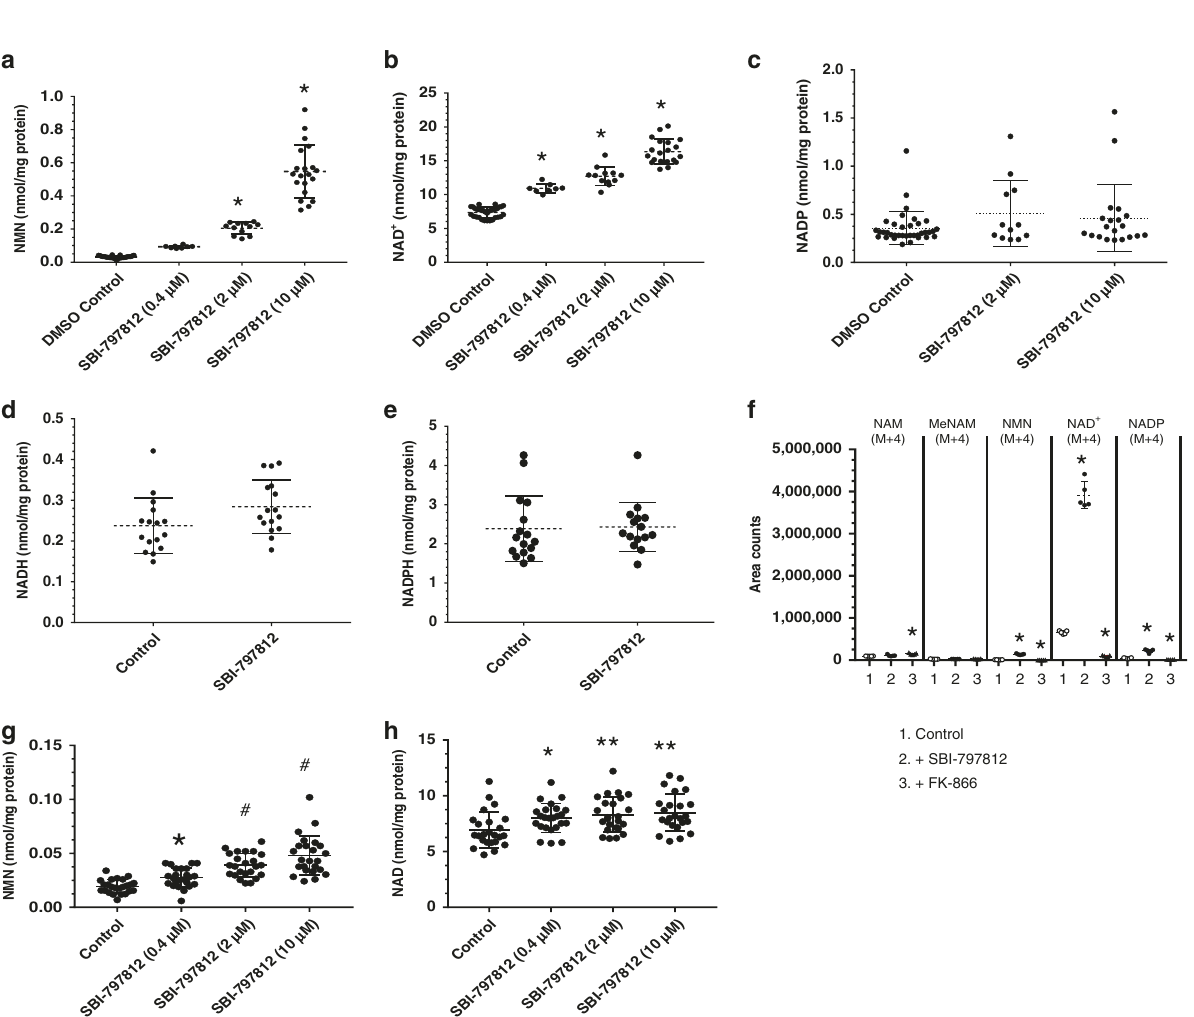
Fig. 4 Effects of SBI-797812 on NAMPT activity in cultured cells. A549 cells treated with SBI-797812 for 4 h. NMN ( a ), NAD + ( b ), and NADP ( c ) were measured by LC-MS/MS. Data shows means ±s.d.; * p < 0.0001 vs. DMSO. NMN: n = 35, 8, 12, 20 for vehicle, 0.4, 2, 10 μ M SBI-797812, respectively; NAD + : n = 32, 8, 12, 20 for vehicle, 0.4, 2, 10 μ M SBI-797812; NADP: n = 36, 12, 20 for vehicle, 2, 10 μ M SBI-797812. One-way ANOVA with Tukey ’ s multiple comparisons test. NADH ( d ) or NADPH ( e ) were not increased in A549 cells treated with SBI-797812 (10 μ M) for 4 h. NADH and NADPH were assayed by LC-MS/MS. Data shows means ±s.d. n = 16 except for NADPH (SBI-797812), n = 15. f NAD + biosynthesis in A549 cells treated for 4h with vehicle, SBI- 797812 (10 μ M) or FK-866 (1 μ M), and 13 C/ 15 N-NAM (20 μ M). NAM(M + 4), MeNAM(M + 4), NMN(M + 4), NAD + (M + 4), and NADP(M + 4) were assayed by LC-MS/MS. Data shows means ±s.d.; n = 5. * p <0.001 vs. Control. One-way ANOVA with Dunnett ’ s multiple comparisons test. g , h SBI-797812 increased NMN and NAD + in human primary myotubes. Cells treated with SBI-797812 (0.4, 2, 10 μ M) for 4h. NMN and NAD + quanti fi ed by LC-MS/MS and normalized to cell protein. Data shows means ±s.d.; n = 24. * p <0.05, ** p <0.01, # p = 0.0001 vs. Control. One-way ANOVA with Dunnett ’ s multiple comparisons test. e . f For Fig. 4a – h, source data are provided as a Source Data fi